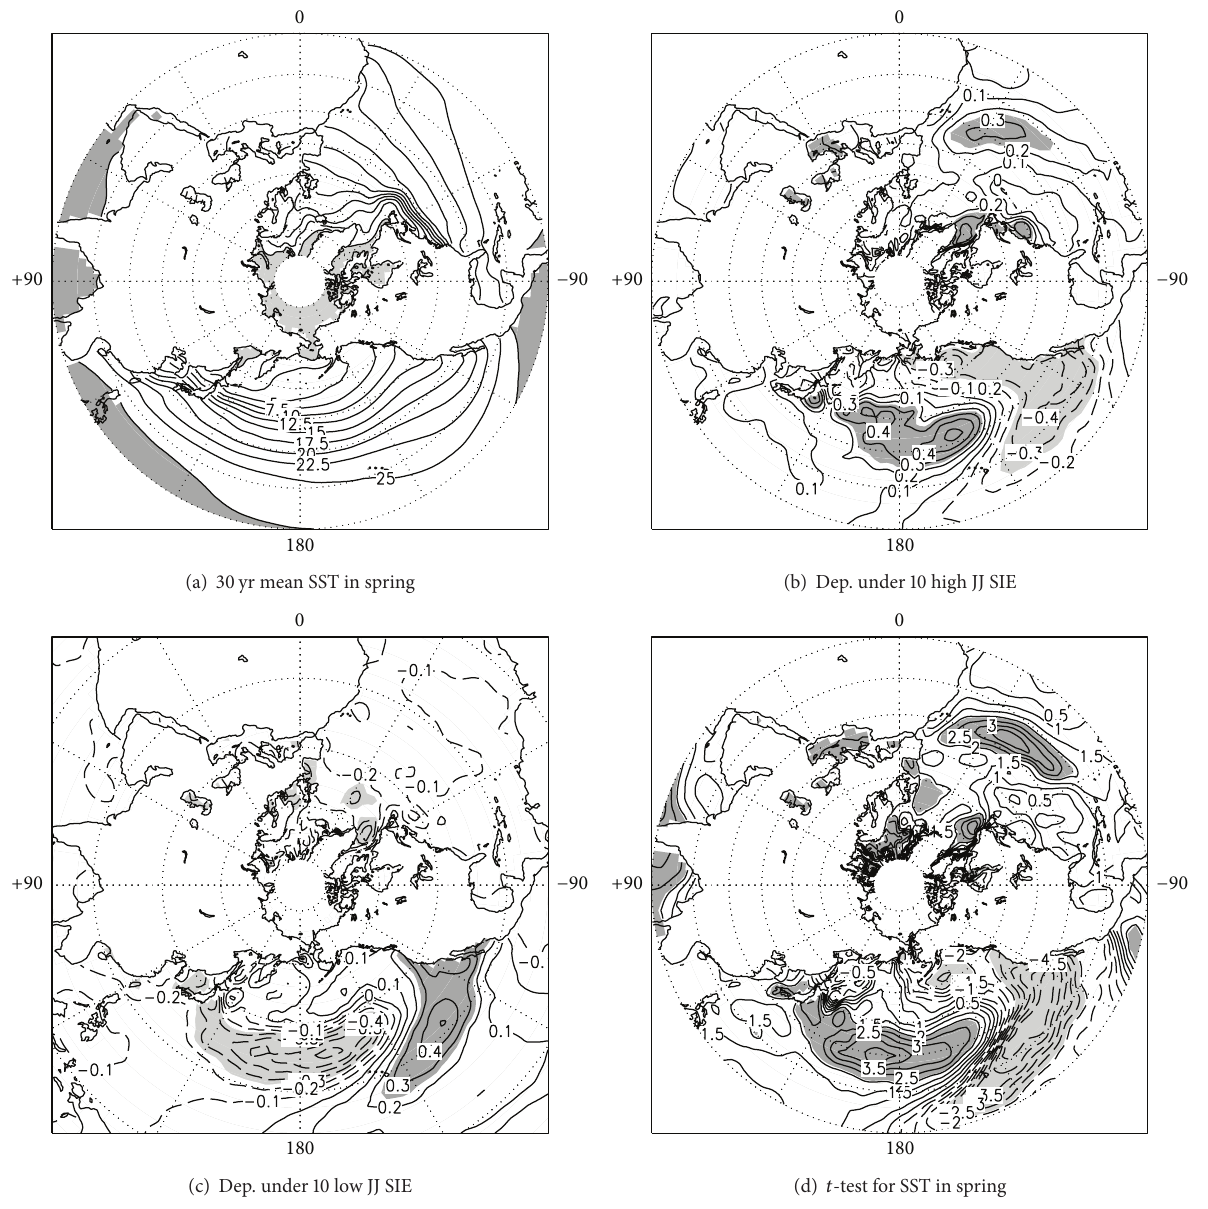
Figure 11: The distributions of surface sea temperature (SST) in spring (MAM) and its associations with the 10 highest and 10 lowest JJ SIE over the north of 10 ∘ N during 1979–2012: (a) a 30 yr average SST in MAM for 1981–2010, (b) departure of average SST for the 10 highest JJ SIE cases relative to the 30 yr average SST in (a), (c) as in (b) but for the 10 lowest JJ SIE cases, and (d) Student’s 𝑡 -test scores of SST for 10 highest and 10 lowest JJ SIE cases.